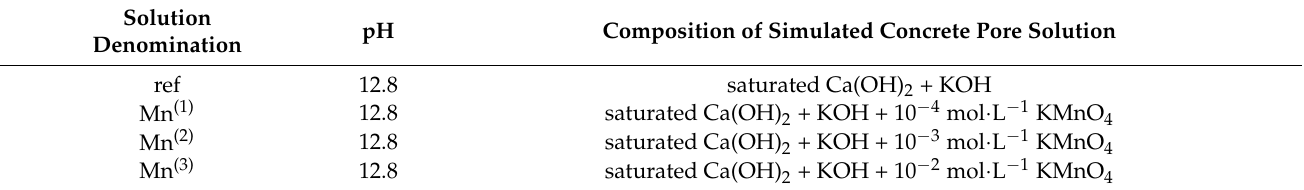
Table 2. Detail characterization of simulated concrete pore solution with KMnO 4